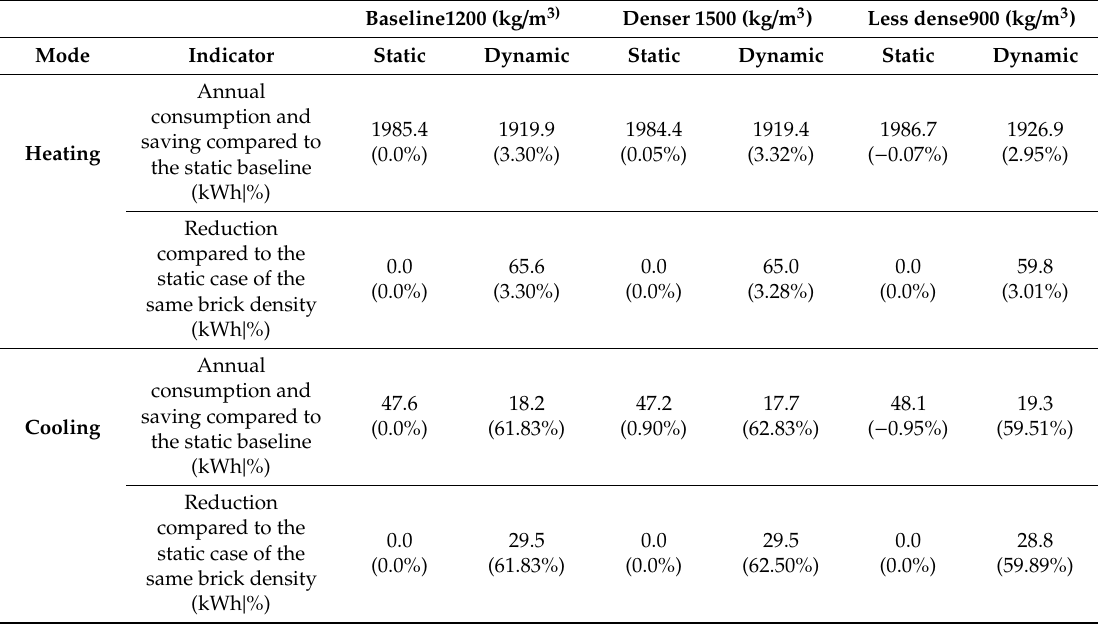
Table 6. Comparison of annual heating and cooling energy consumption for various densities of the interior brick layer of the walls of the typical Belgian